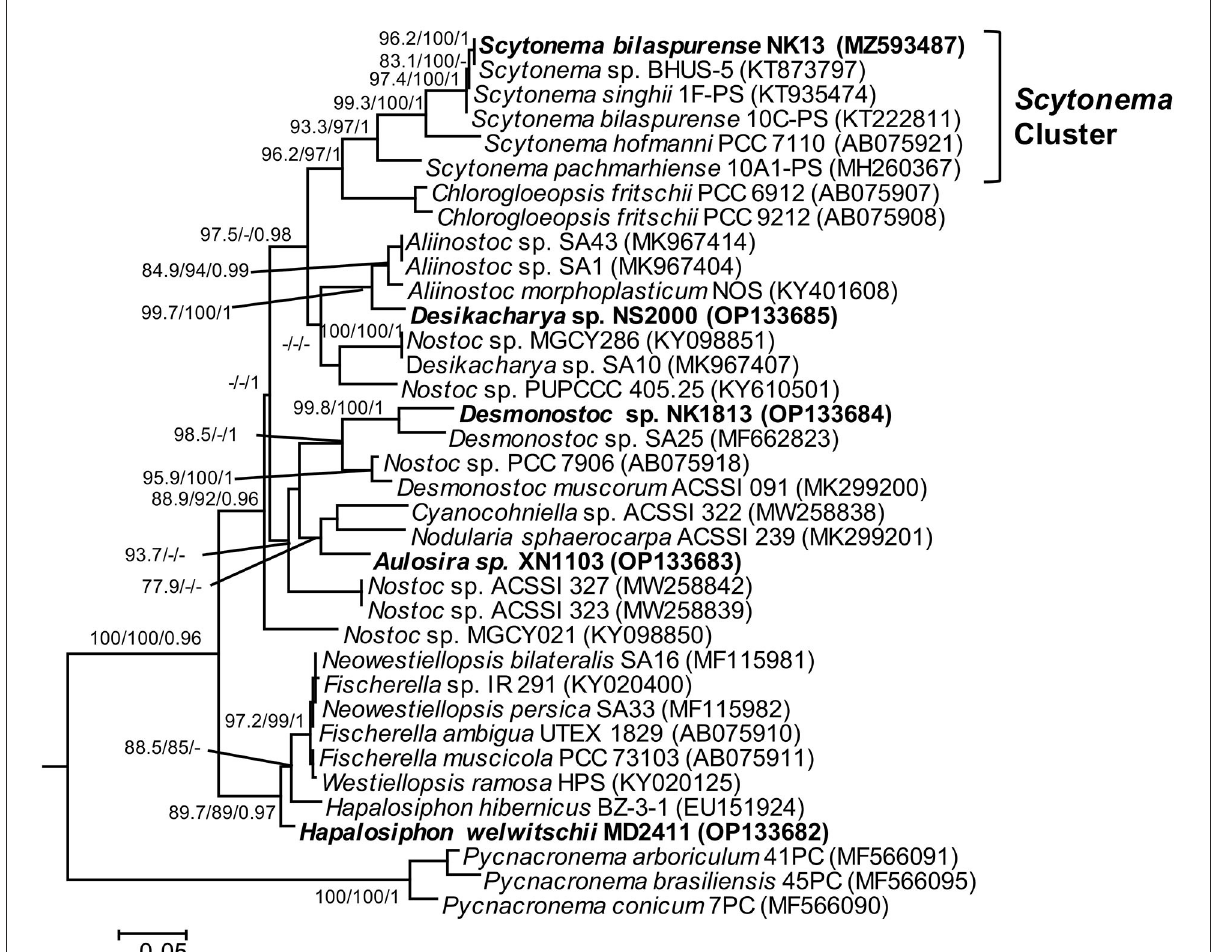
FIGURE3 Phylogram derived from maximum likelihood (ML) analyses of rbcL sequence dataset. The analyses were conducted for 10 independent runs using MrBayes v3.2.5, and each run was carried out for 5 million generations by applying the GRT + G + I substitution model. The likelihood ratio test (SH-aLRT) (%) and ultrafast bootstrap support (BS) (%) values of IQTREE > 75% and Bayesian posterior probabilities (BPP) > 0.95 are indicated at nodes as SH-aLRT/BS/BPP. Scale bar indicates estimated substitutions per